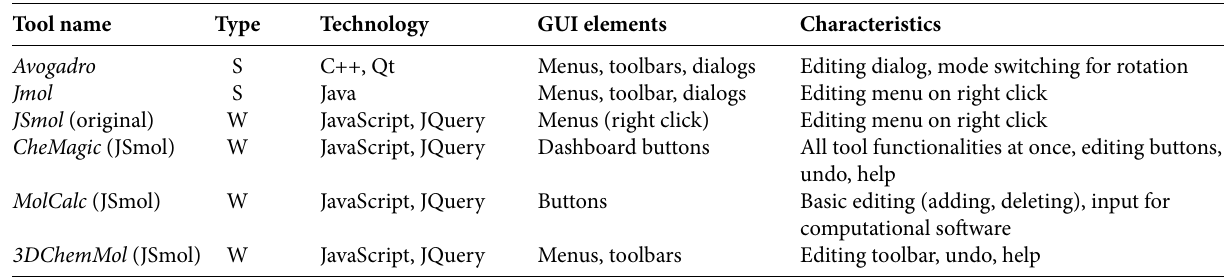
Table 1: Characteristics of selected freely available user interfaces for 3D model building Tool